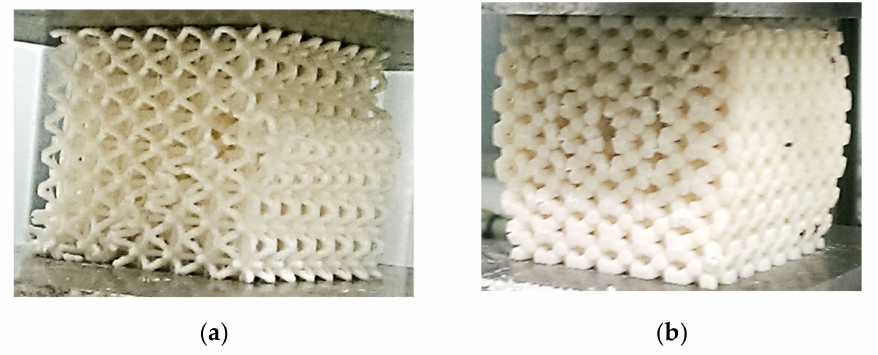
Figure 11. Crack propagation at the lattice structures: ( a ) a = 5 mm and V r = 25%; ( b ) a = 7 mm and V r =